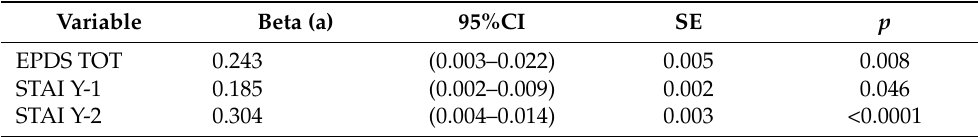
Table 9. Multiple linear regression (MIBS dependent